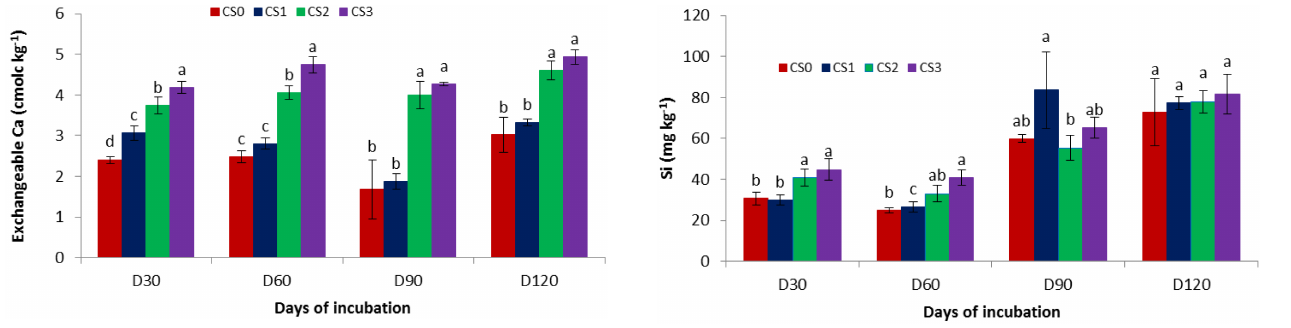
Figure 4. Effects of calcium silicate application on silicon content. Means marked with the same letter for each incubation day are not significantly different at p< 0 . 05 (Tukey’s